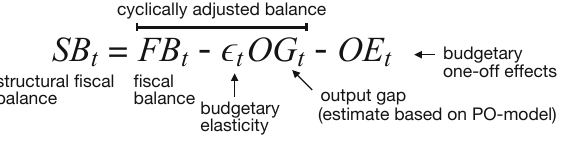
Source: Heimberger and Kapeller